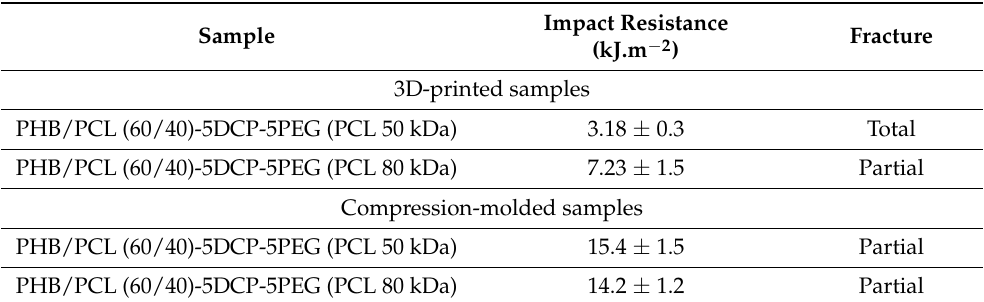
Table 5. Comparison of the effect of PCL molecular weight on the 3D-printed and compression- molded specimens’ impact